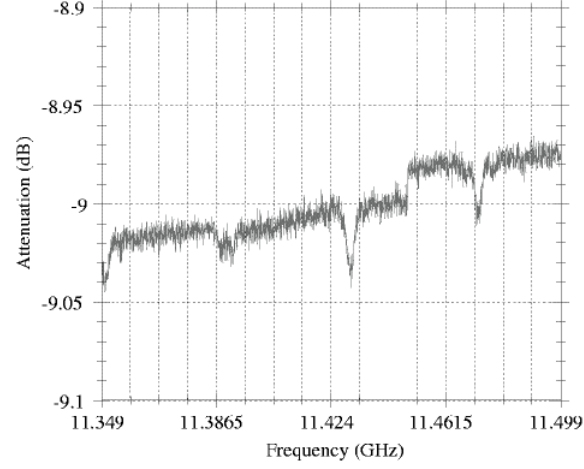
TABLE I. Modal connection between circular and square waveguides. Circular guide